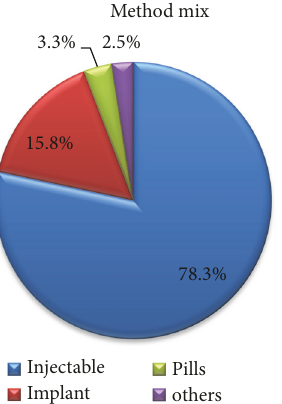
Figure 3: Method mix of women in extended postpartum period in Tahtay Koraro, Ethiopia,